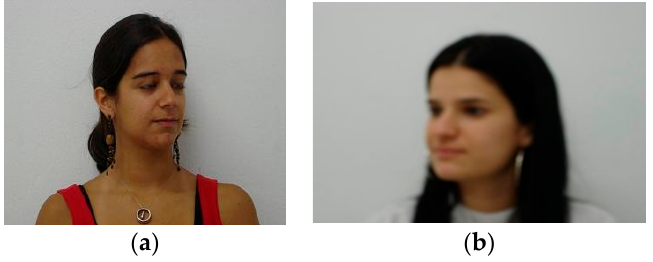
Figure 16. Example with closed eyes ( a ) and of a blurry image ( b ) from the FEI database.